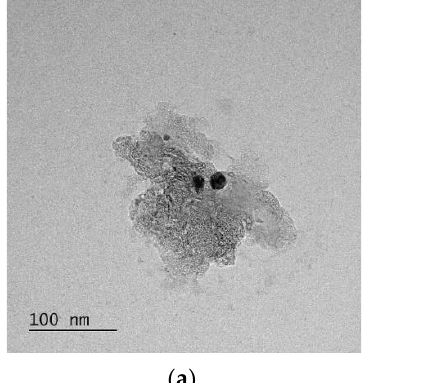
Figure 5. TEM images for Mg 65 Zn 30 Ca 4 Ag 1 milled for 50 h. ( a ) Bright field image, ( b ) dark field im- age, ( c ) SAED pattern from tested region.